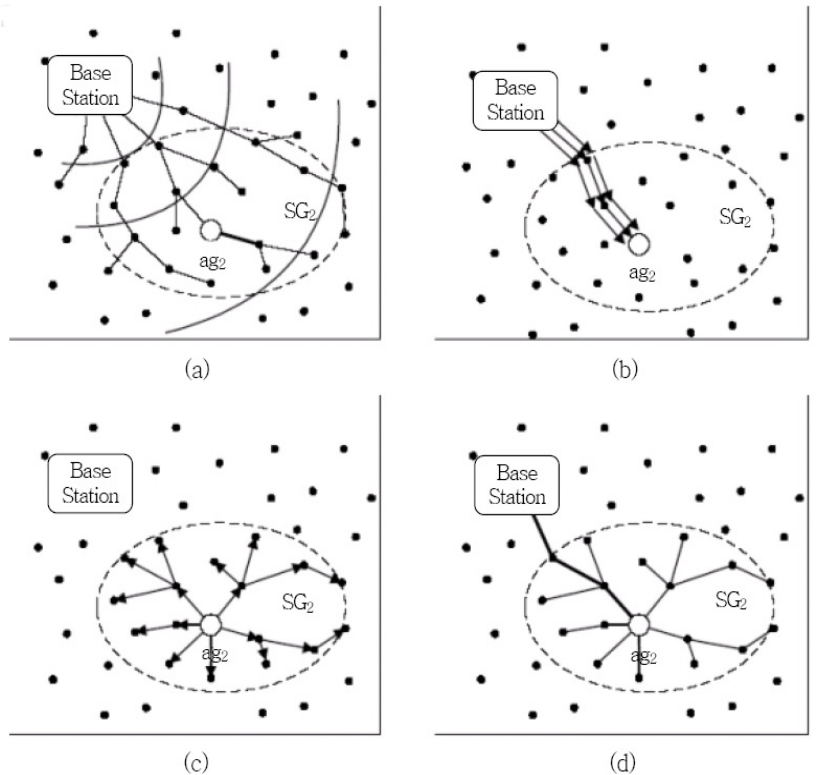
Figure 1. Group key management